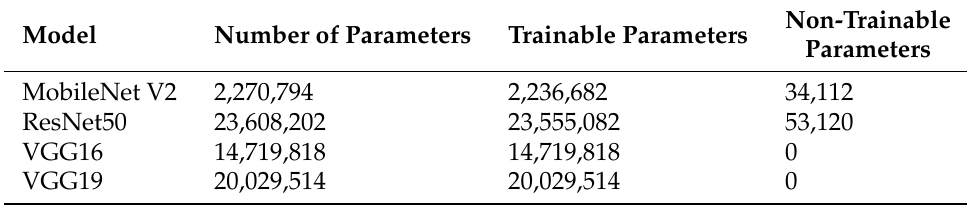
Table 2. Number of parameters used for each model